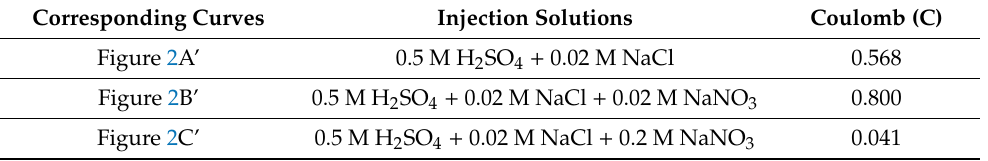
Table 2. The integral electrical quantity after the injection (the integral time is 100–200 s). Corresponding